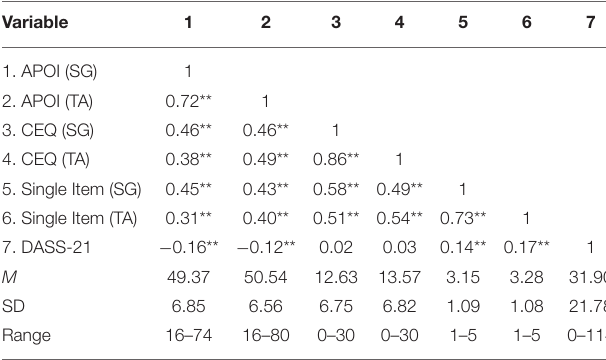
TABLE 2 | Means, standard deviations, and correlations between acceptability of iCBT and indicators of mental health symptomatology.